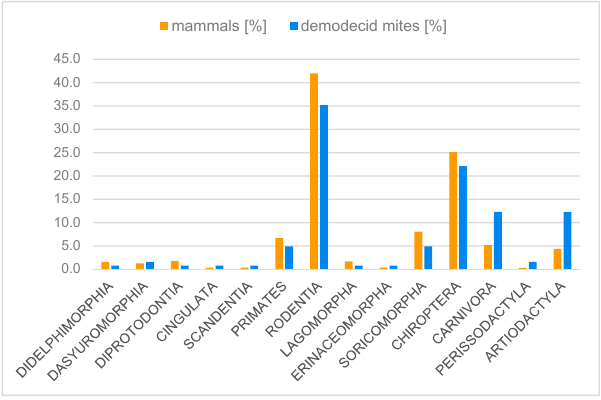
Figure 3. Share (%) of species from particular orders within mammals in comparison with the participation (%) of related demodecid mites. Diversity 2020 , 12 , x FOR PEER REVIEW